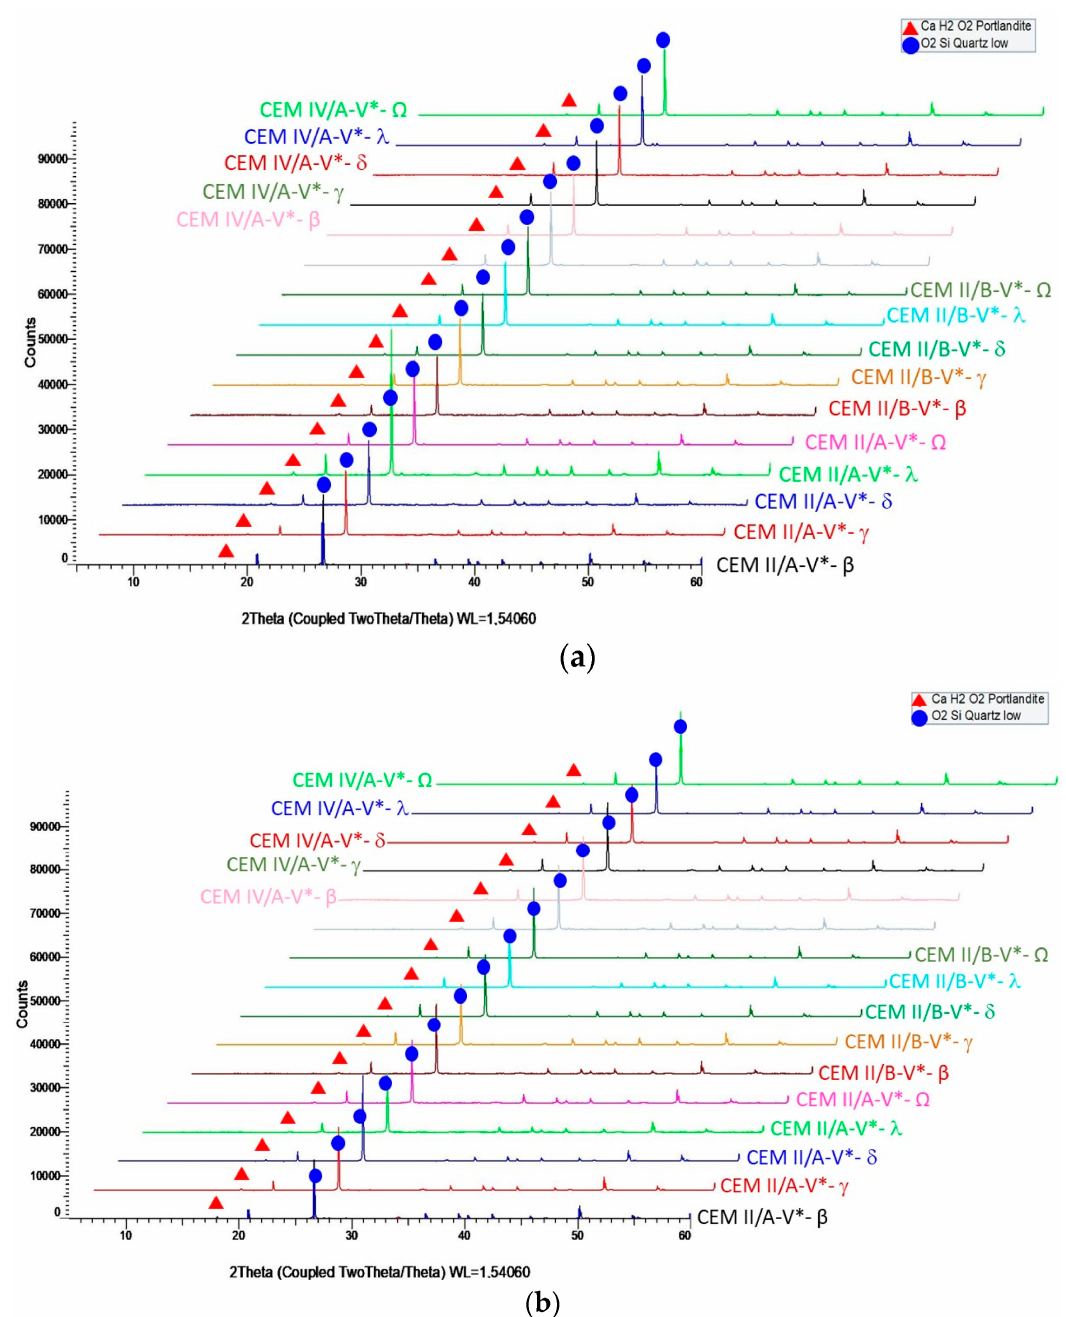
Figure 17. X-ray diffraction of mortars at 28 days ( a ) and 90 days ( b